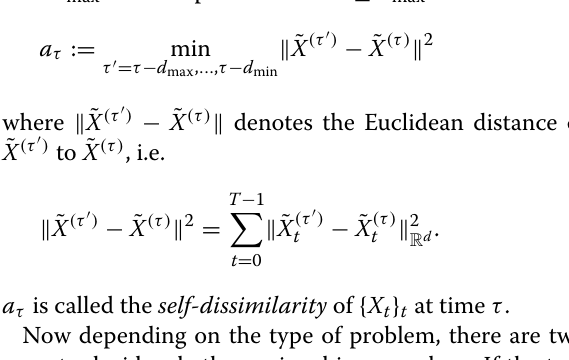
in Section 3.1 is applied to training, validation, and